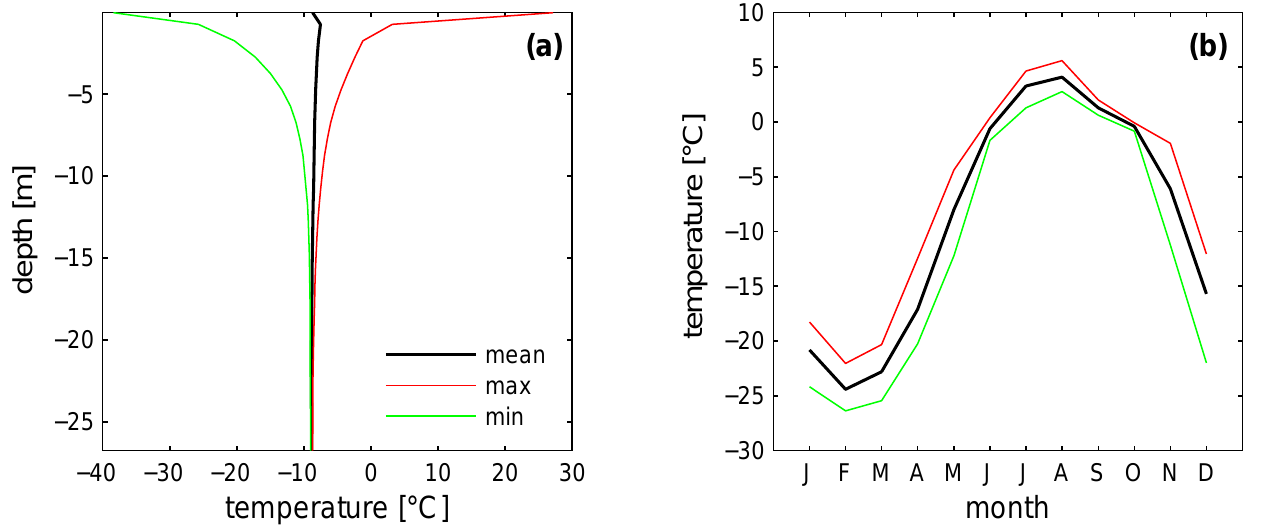
Fig. 9. Mean, maximum, and minimum monthly temperatures for the deep (27m) borehole on Samoylov Island, from 2006–2011 (a) , and mean, maximum, minimum monthly temperature for a polygon dry rim site (0.21m depth) from 2002–2011 (b) .